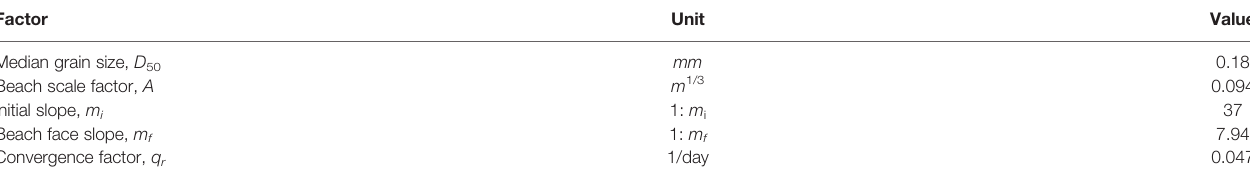
TABLE 1 | Input conditions for prediction result of shoreline evolution. Factor